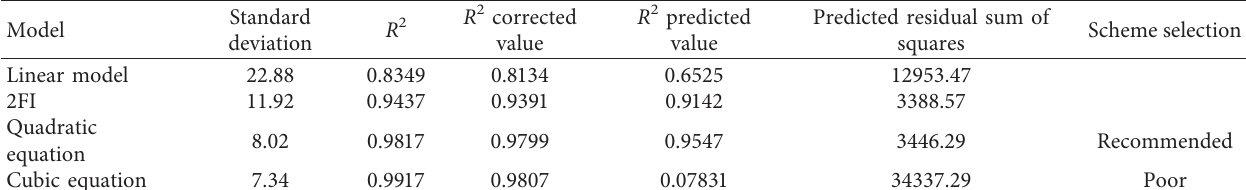
Table 6: Comprehensive evaluation of R 2 of burnout